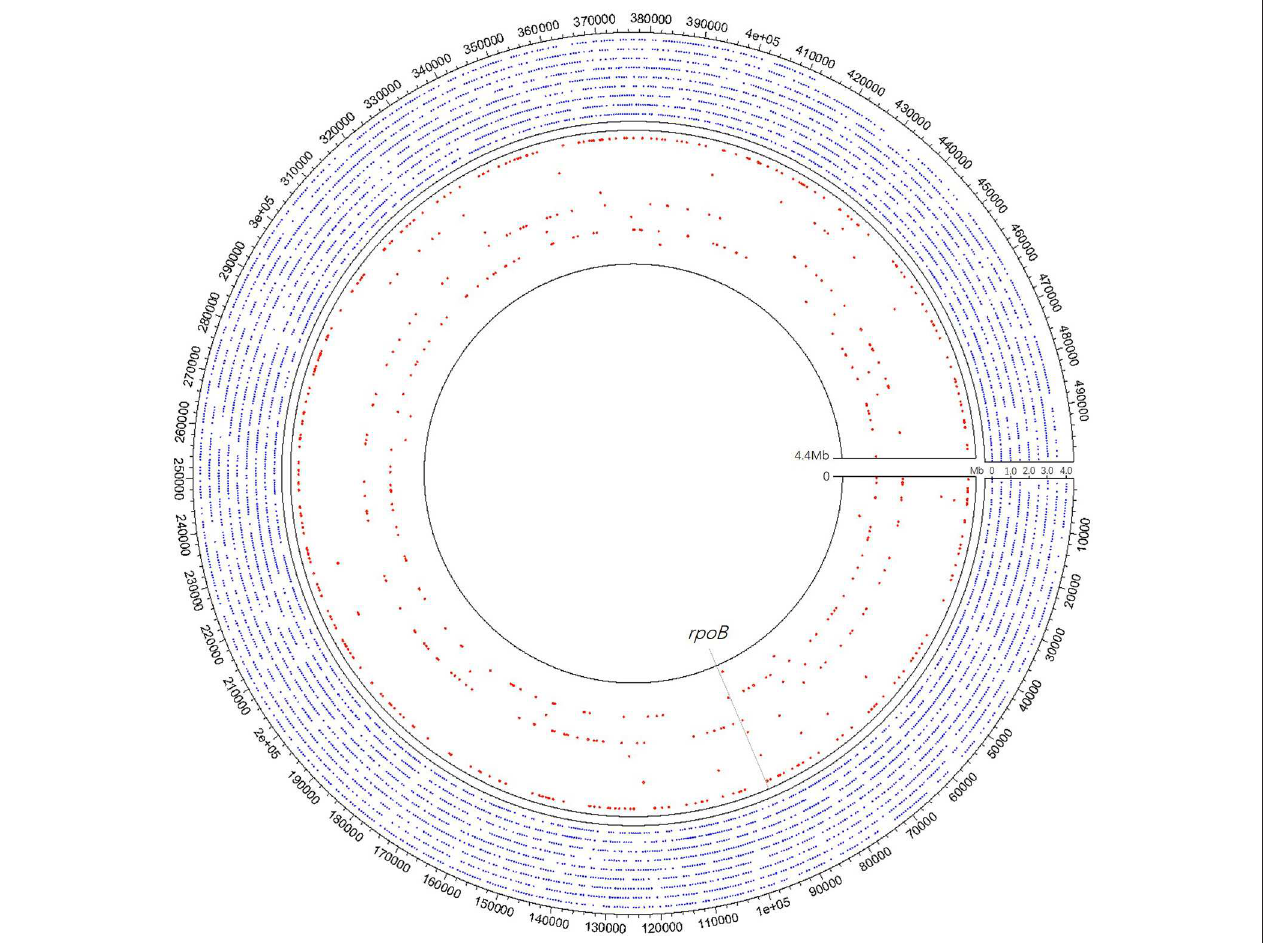
FIGURE 3 | A schematic diagram of mNGS of 10 samples’ genomic coverage across M. tuberculosis reference genome. The result shows that mNGS was able to detect much more region of the genome apart from rpoB . Outer nine circles of the blue dot area all refer to one pus sample of coverage 18.73%, of which each circle represents 0.5Mb of the genome. Each of the nine red circles of the inner layer represents one sample. The gray dotted line represents the rpoB